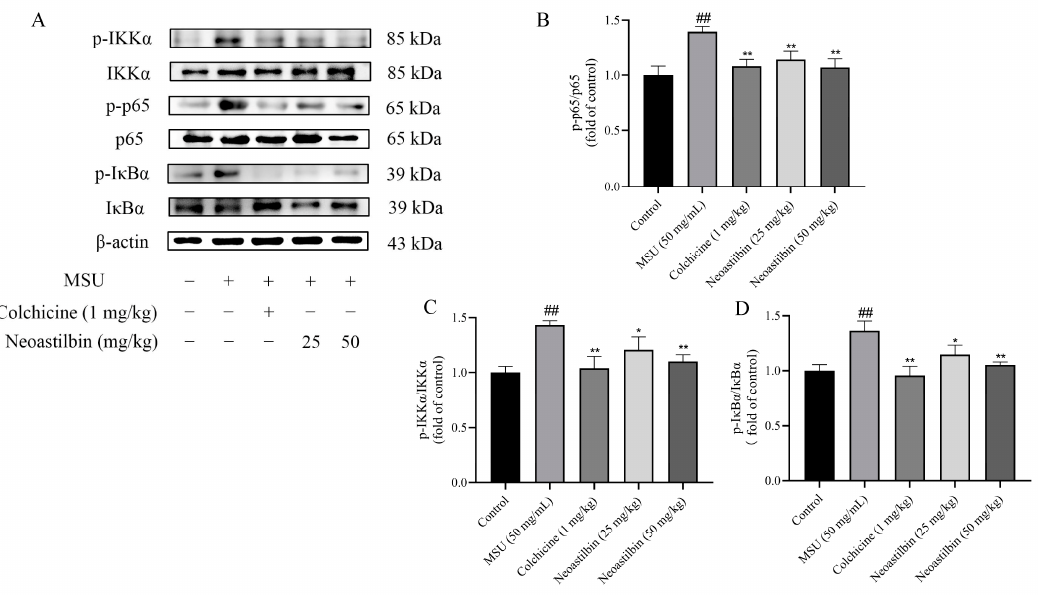
Figure 9. Effects of neoastilbin on protein expression of NF- κ B pathway in GA mice. ( A ) Phosphorylated and non-phosphorylated expressions of IKK α , p65 and I κ B α . ( B – D ) The ratio of protein expression of p- IKK α /IKK α , p-p65/p65 and p- I κ B α /I κ B α . Data in the figures represent the means ± SD; significant differences among different groups are indicated as ## p < 0.01 vs. control group, * p < 0.05, ** p < 0.01 vs. MSU group ( n = 3).